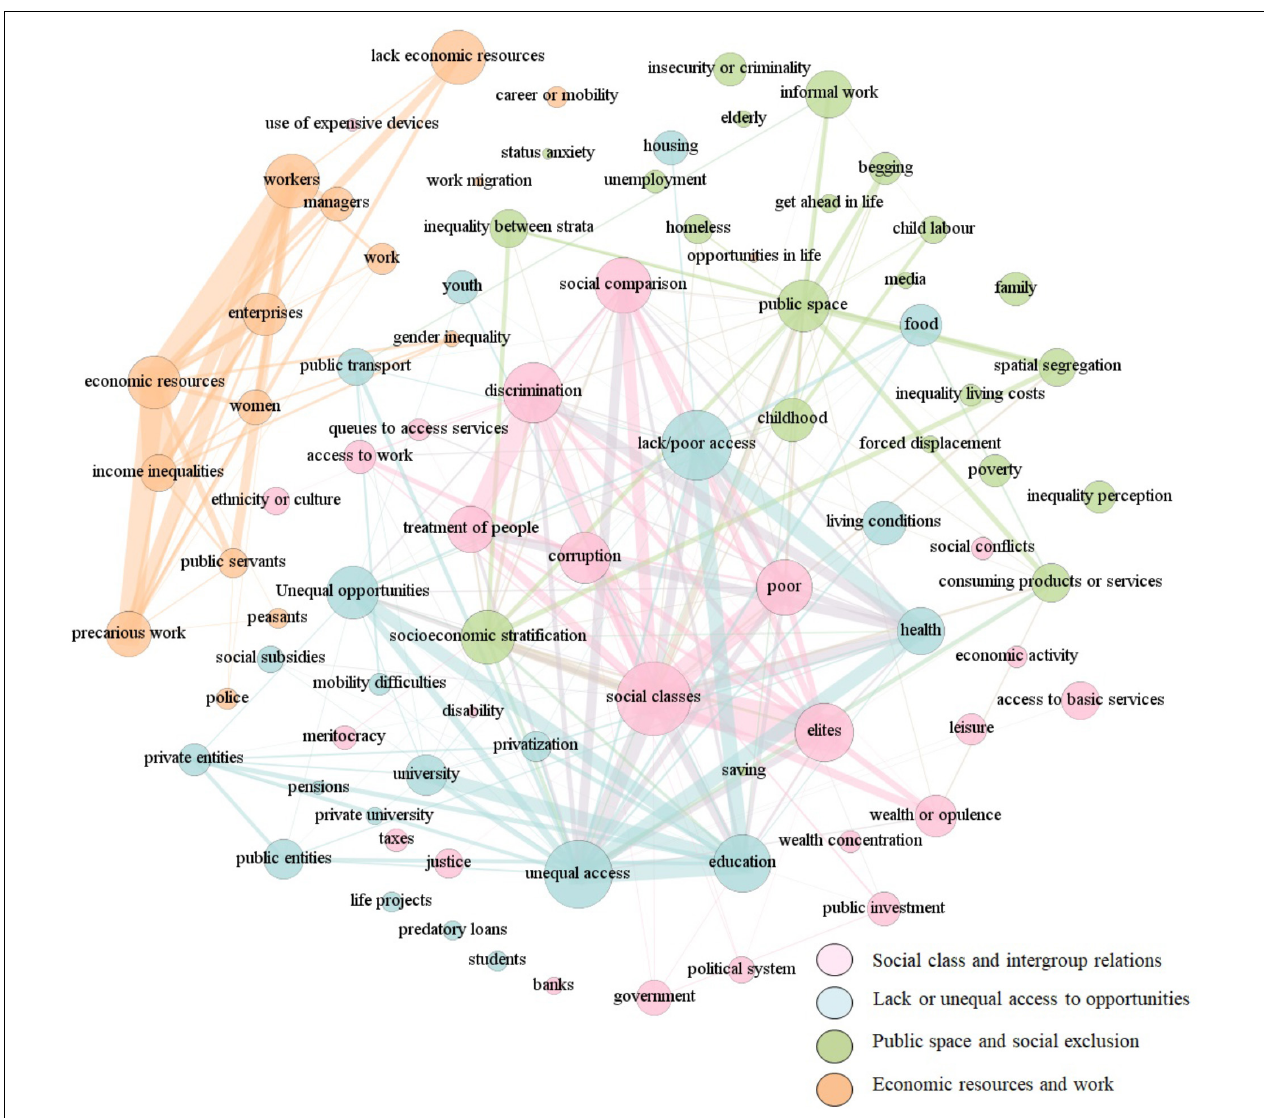
FIGURE 1 | Perceptions of economic inequality graph based on co-occurrence matrix with clusters marked in